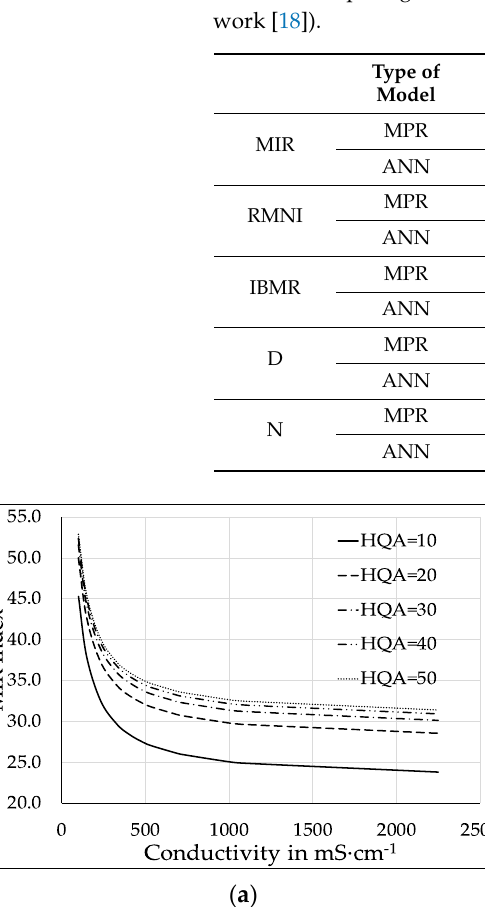
Figure 1. ( a ) HQA-conductivity nonlinear relationship with MIR; ( b ) importance ratio of independent variables with MIR.